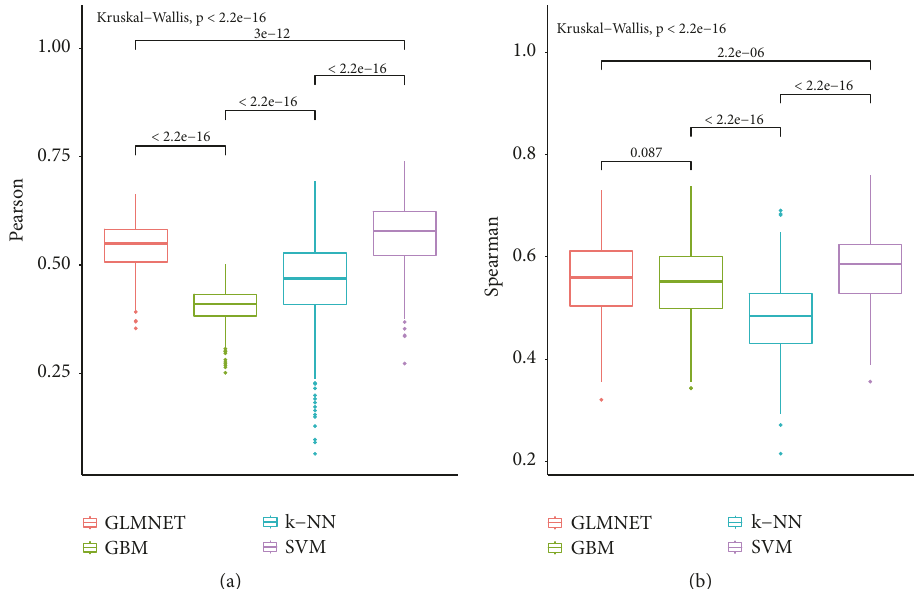
Figure 6: Distribution of the correlations obtained for each optimised model (Pearson’s on the right and Spearman’s on the left). For each pair, the p-value obtained using a Kruskal-Wallis test is shown.